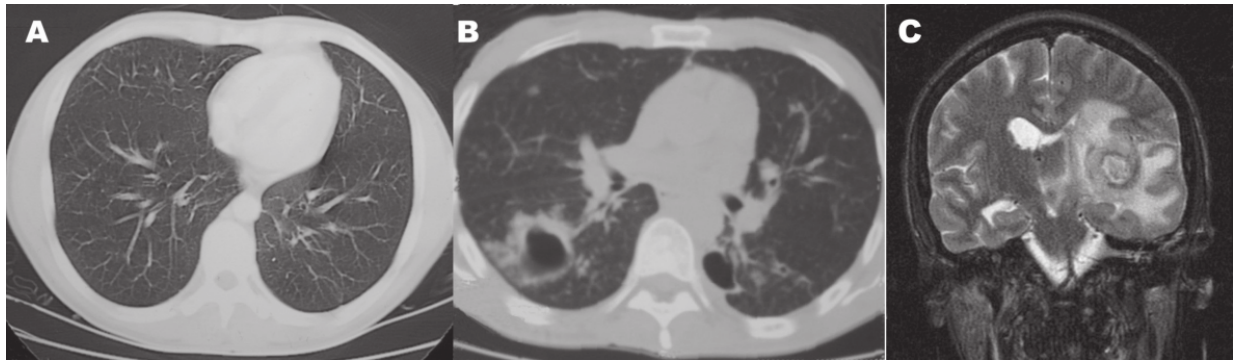
Figure 1 - Thorax CT-scan showing a lung abscess in a patient with Rhodococcus equi bacteremia (B). The normal CT-scan 1 month before symptoms (A). Magnetic resonance with a brain abscess (C).